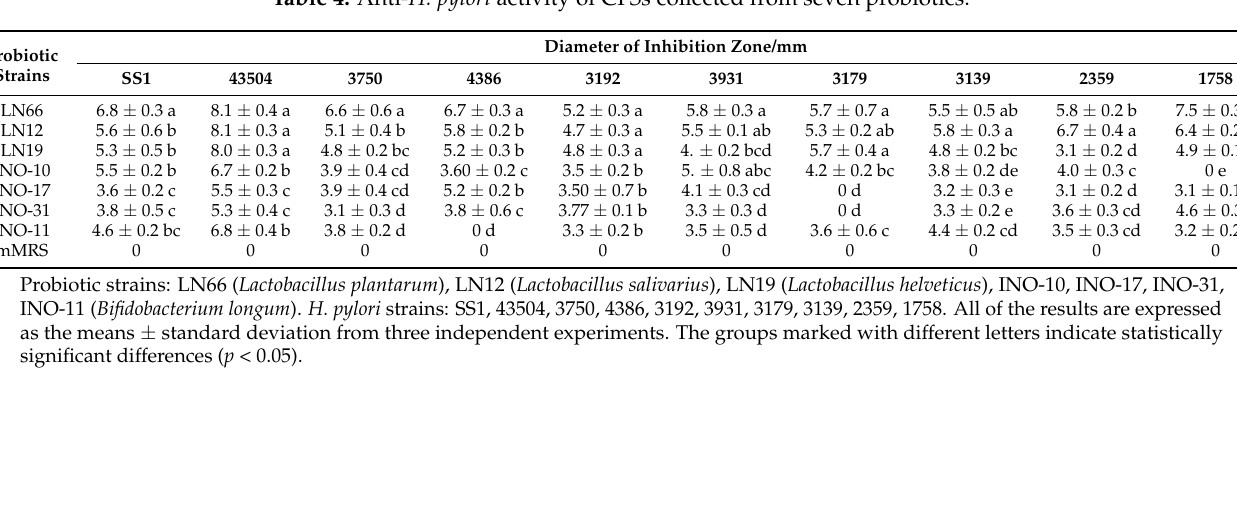
Table 4. Anti- H. pylori activity of CFSs collected from seven probiotics.